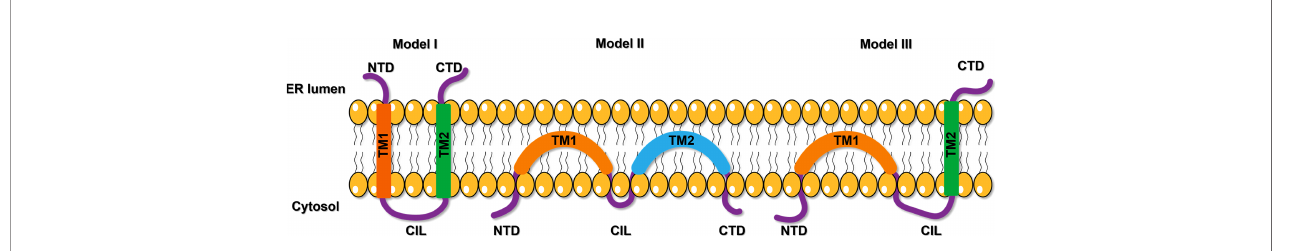
FIGURE 1 | The proposed models of IFITM protein topology. The fi rst model suggests a kind of transmembrane protein with transmembrane NTD and CTD facing extracellular. The second model shows NTD, CTD, and CIL were all located in the cytoplasm, and the two hydrophobic domains (IMD and TMD) folded back in the membrane but did not cross the membrane. The third model proposes a type II transmembrane topology, with its NTD and CIL located in the cytoplasm, while the CTD is located in the extracellular domain. NTD, N-terminal domain; CTD, C-terminal domain; TM, transmembrane domain; CIL, intracellular cyclic loop;